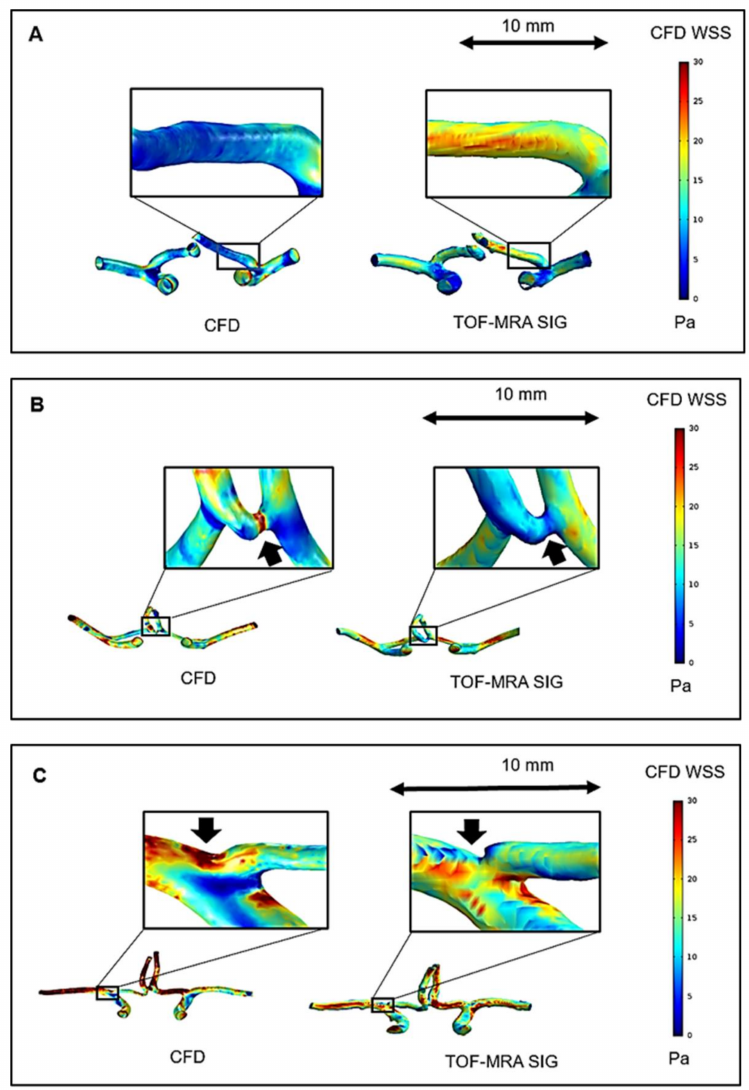
Figure 5. Comparison of CFD WSS with TOF-MRA SIG. The visualization was very different between the two techniques at the ACA ( A ), ACoA ( B ), and ICA bifurcation ( C